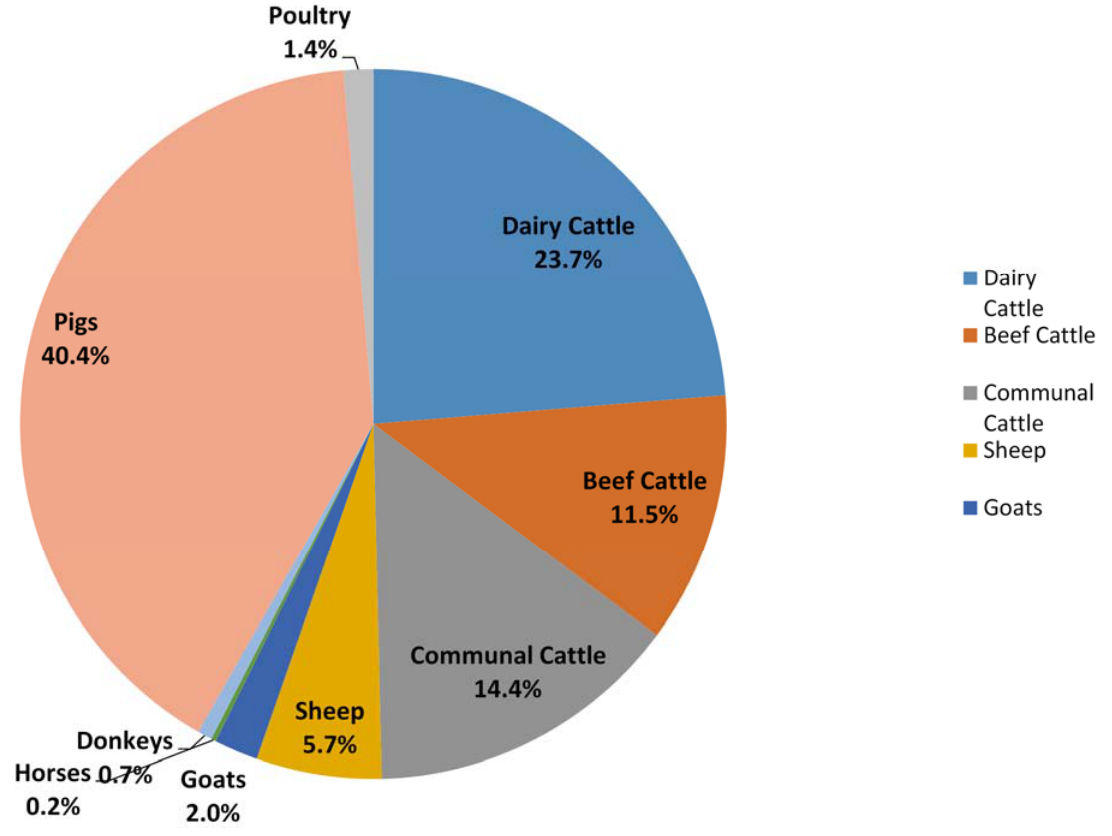
Figure 1. CH emissions from manure management per livestock category in 4 Figure 1. CH 4 emissions from manure management per livestock category in 2004.